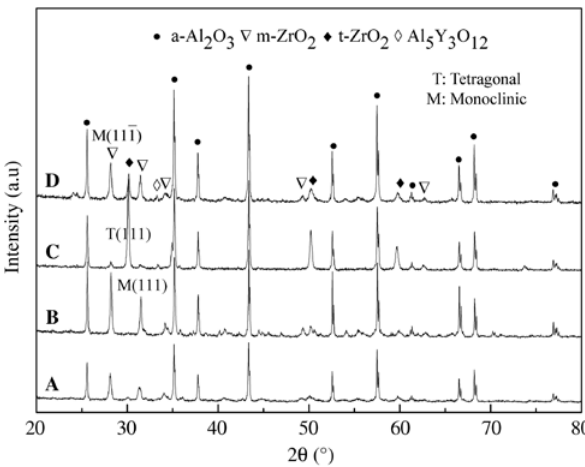
Figure 5 Hot modulus of rupture of samples at 1400 °